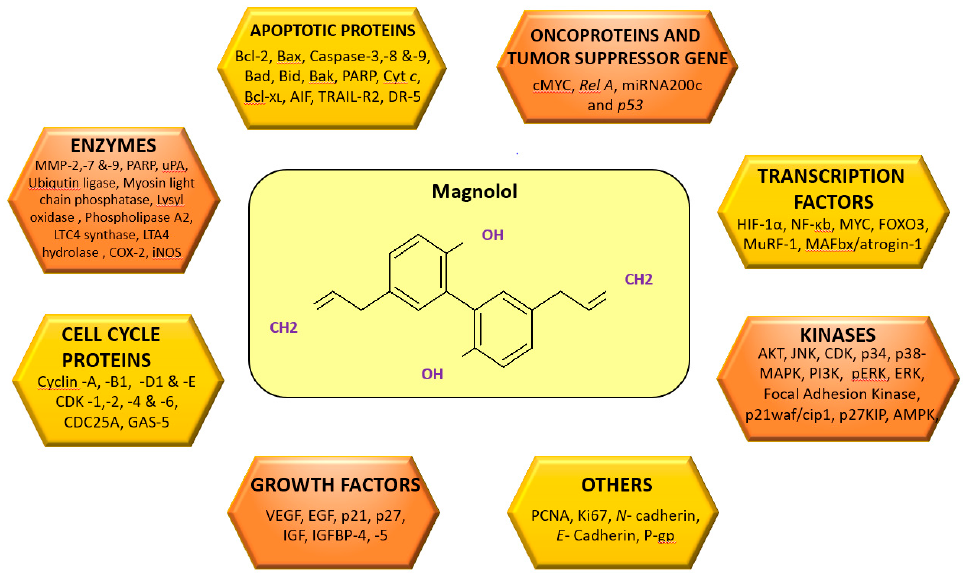
Figure 2. Various molecular targets modulated upon magnolol treatment.